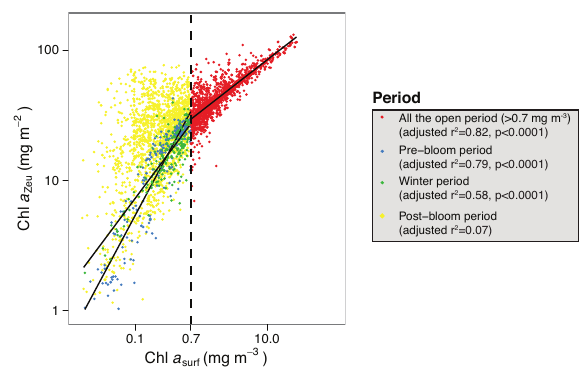
Fig. 6. Integrated chlorophyll a concentration over the euphotic zone (Chl a Z ; based on the empirical relationships of Morel and EU Maritorena, 2001) plotted as a function of the surface Chl a concen- tration (Chl a surf ) for the three distinct time periods (i.e., pre-bloom, post-bloom, winter, and the open water period > 0.7mgm − 3 ).